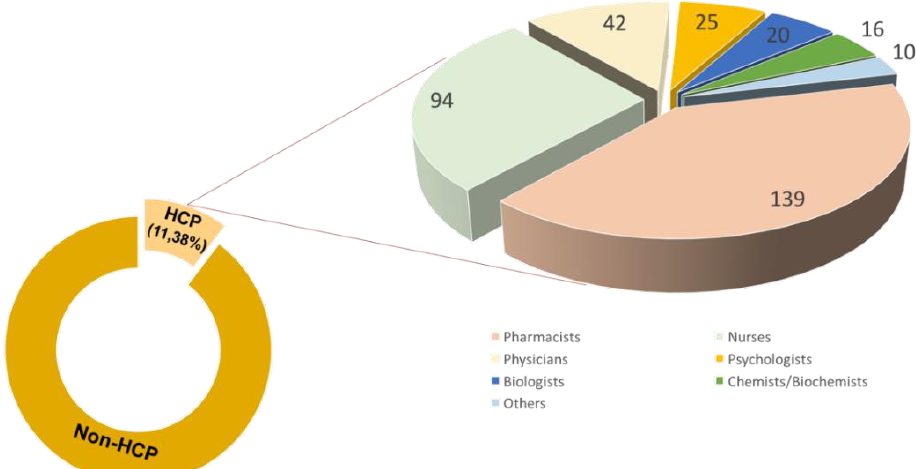
Figure 1. Healthcare professionals in ‘yomevacuno’ network. Where HCP, means healthcare pro- fessionals, and non-HCP means users than do not define themselves as healthcare professionals (including public and private institutions and organizations). Table 1. Messages from healthcare professionals in #yomevacuno network.